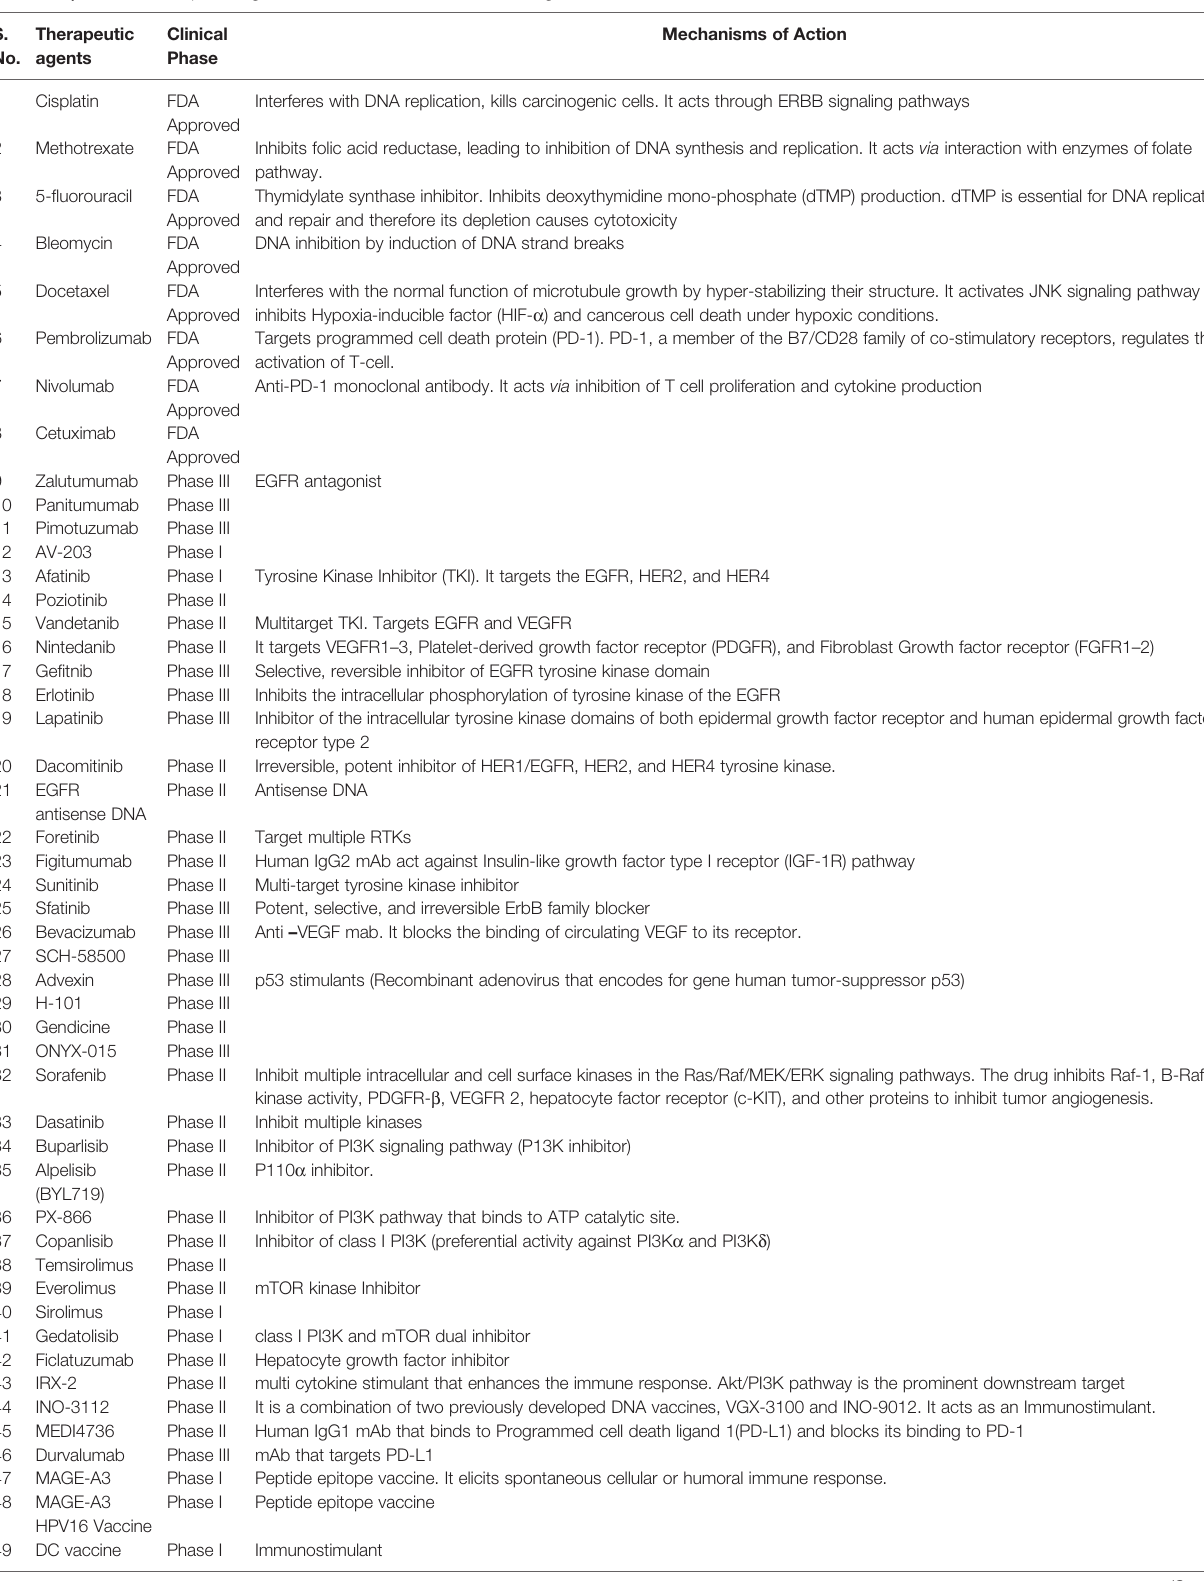
TABLE 6 | A List of Therapeutic agents and Their Mechanism of Action against